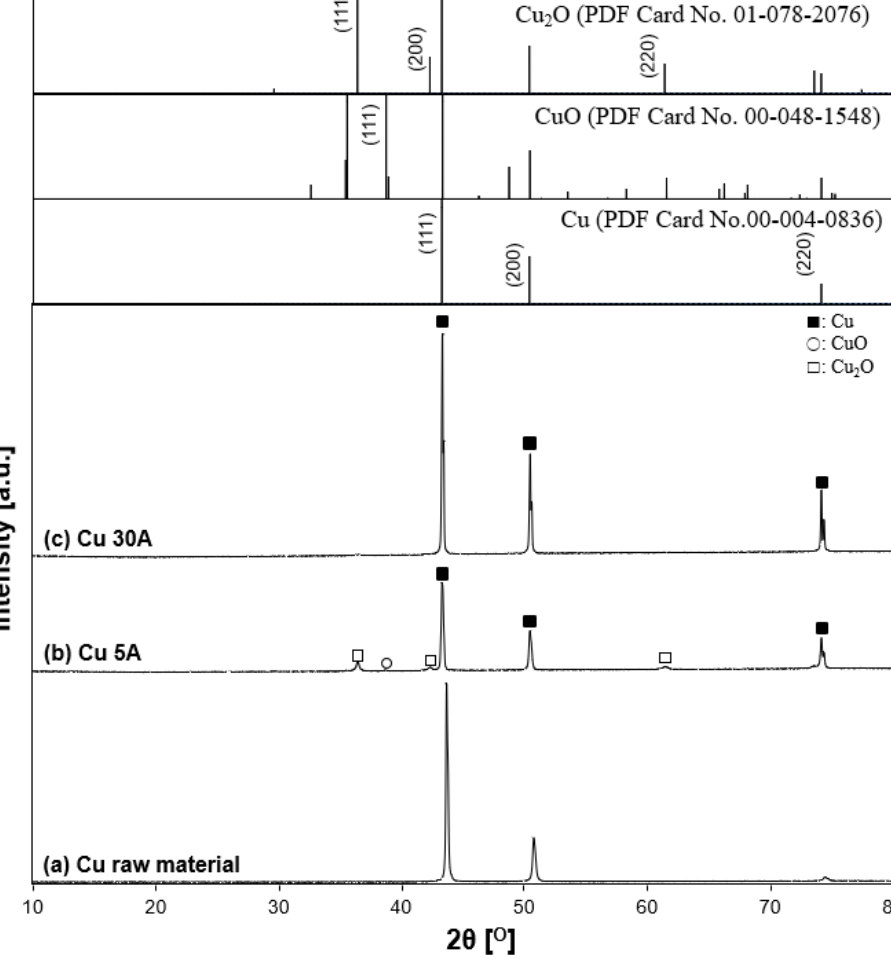
Figure 13. X-ray diffraction patterns of synthesized samples. ( a ) Cu raw material, ( b ) Cu 5 A, ( c ) and Cu 30 A. The inserted figure is the JCPDS PDF card of the Cu, CuO, Cu 2 O XRD patterns. Individual crystalline phases are represented by the following characteristic peaks: ( ■ ) Cu, ( ○ ) CuO, and (□) Cu 2 O. ( (cid:3) ) Cu 2